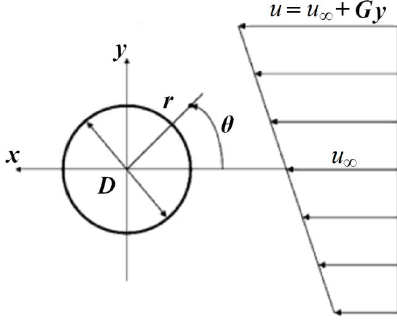
Figure 2. Sketch of shear flow over circular cylinder.